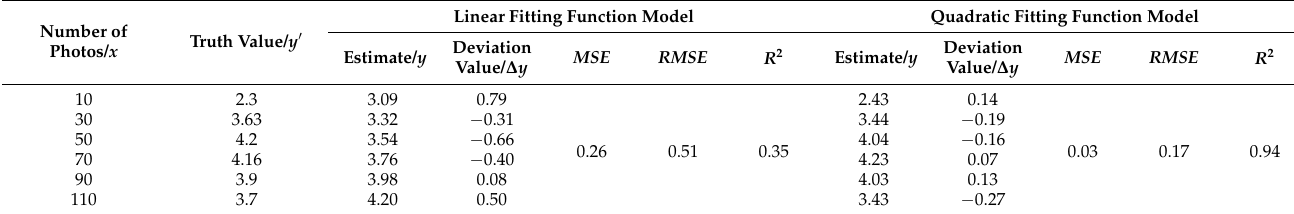
Table 7. Statistics of deviation value of function